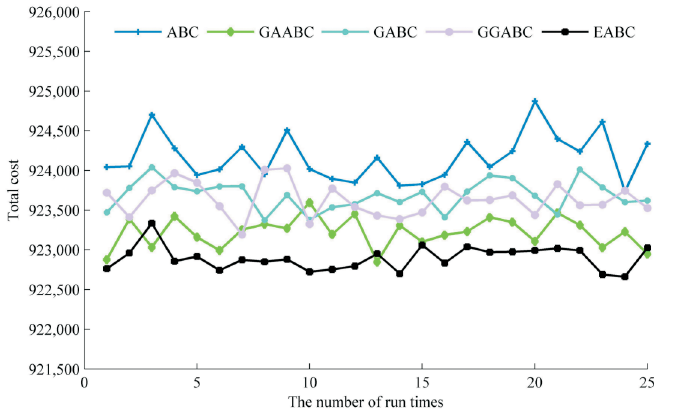
Fig 4. The best cost of each run time.